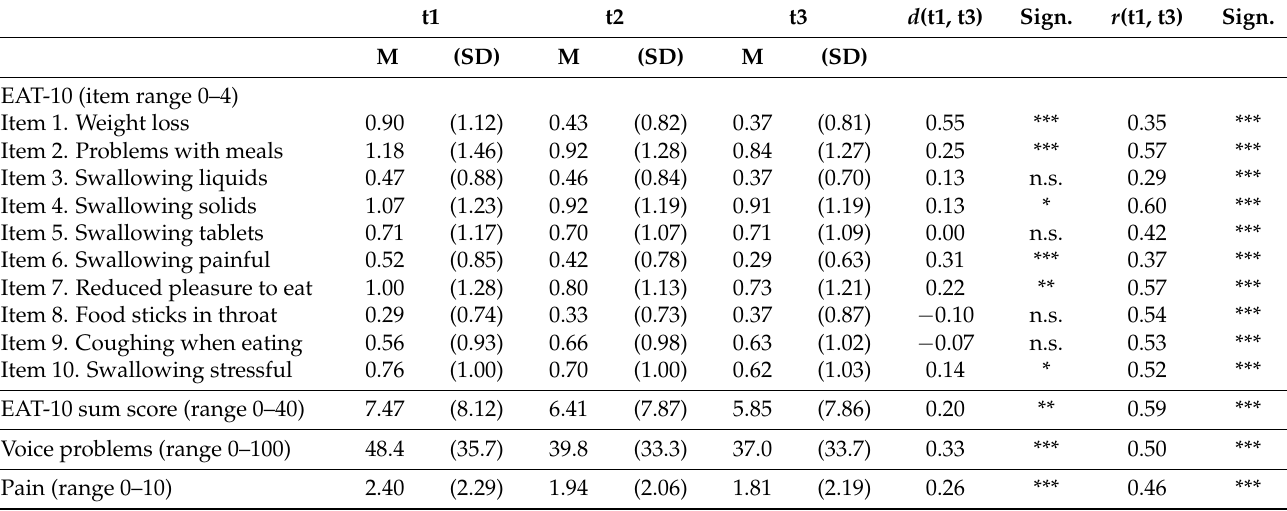
Table 2. Mean scores for the three measurement points, effect sizes for the t1–t3 comparison and correlations between t1 and